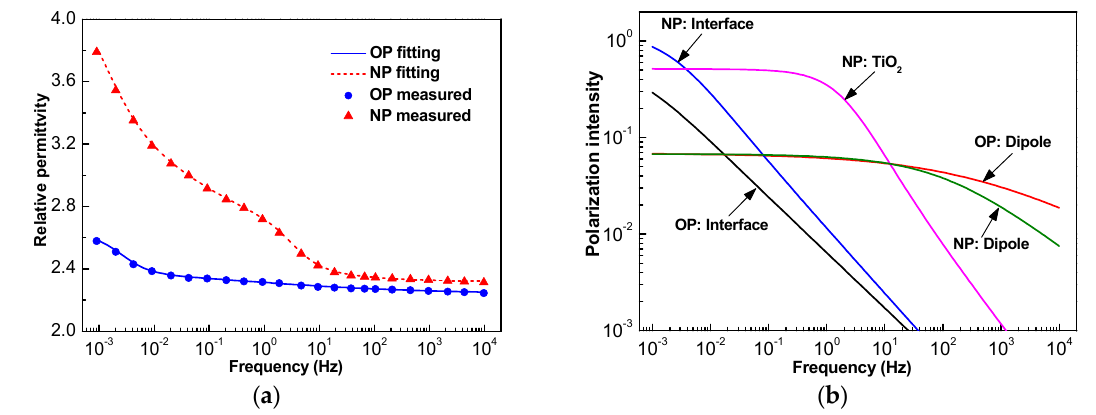
Figure 4. Frequency domain spectrum of oil-impregnated paper (OP) and nanofluid-impregnated paper (NP): ( a ) measured permittivity and its fitting curve; ( b ) their composition of different dielectric relaxation processes.